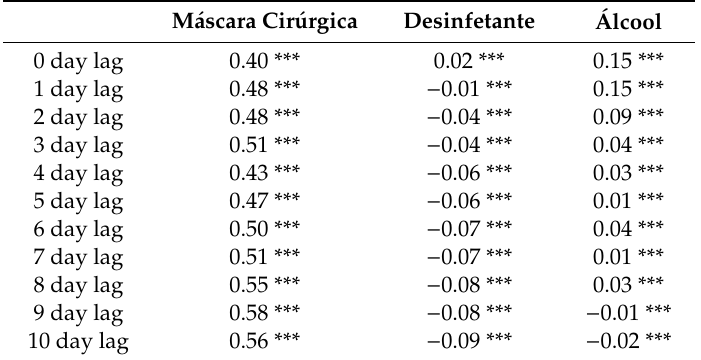
Table 5. Day Lag Correlations between New Cases and the keywords in